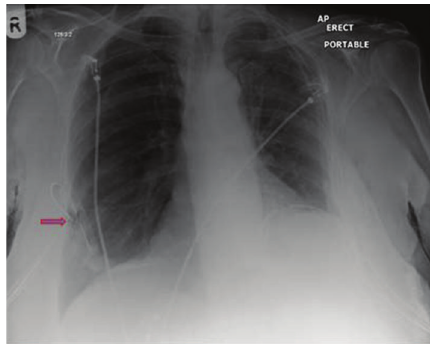
Figure 16: A kink in a chest drain that failed to evacuate the right- sided pleural e ff usion.